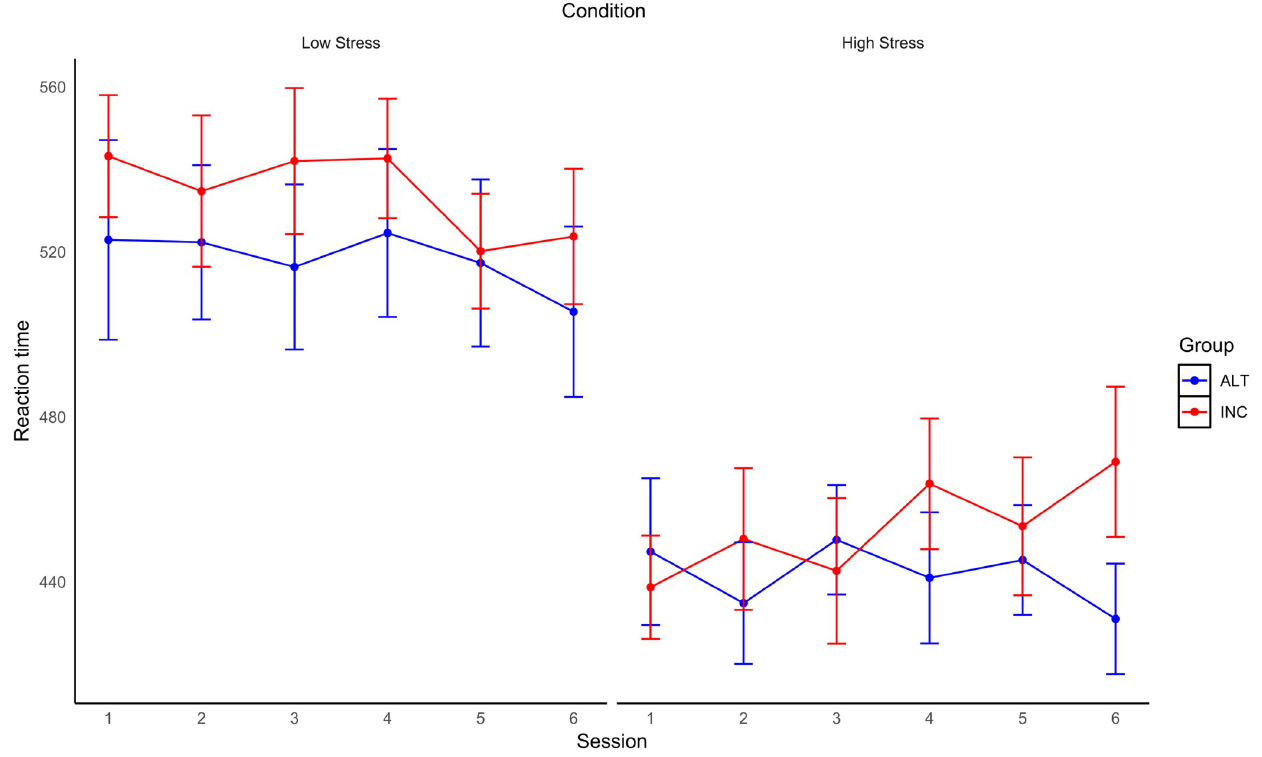
Fig 10. Changes in RTs across sessions in low and high time-stress conditions for each group. RTs to enemy targets over Sessions in the Low (left) and High (right) time-stress conditions for each Group (error bars are SE).